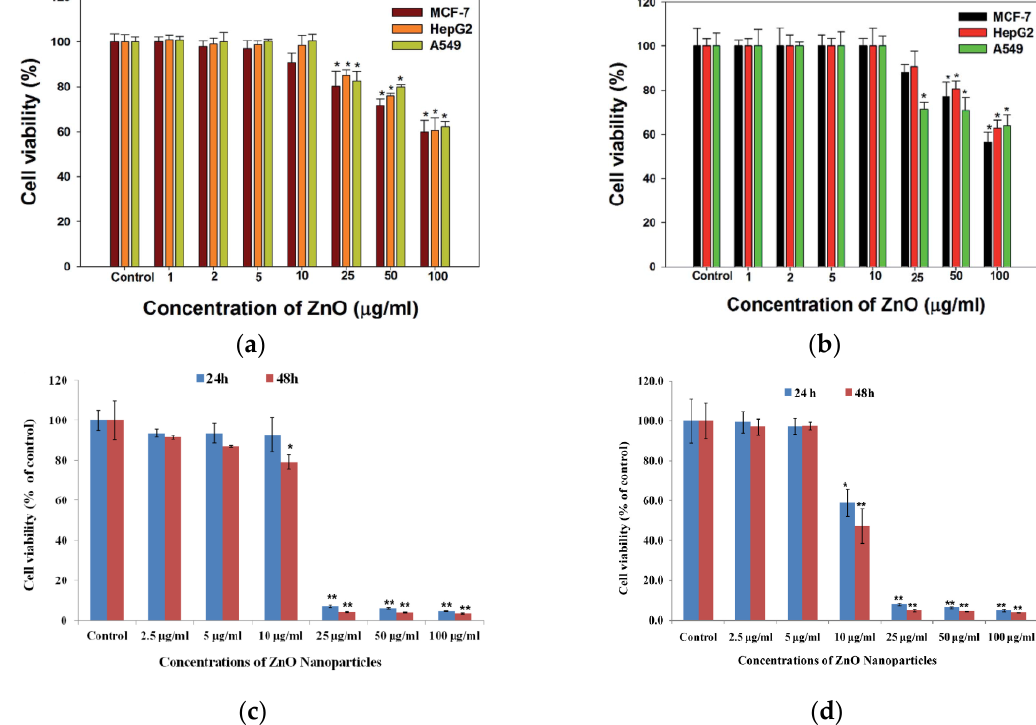
Figure 25. The viability of MCF-7, HepG2 and A549 cells treated with ZnO NPs of different doses for 24 h as determined by ( a ) MTT and ( b ) neutral red uptake (NRU) assays. Error bars indicate standard